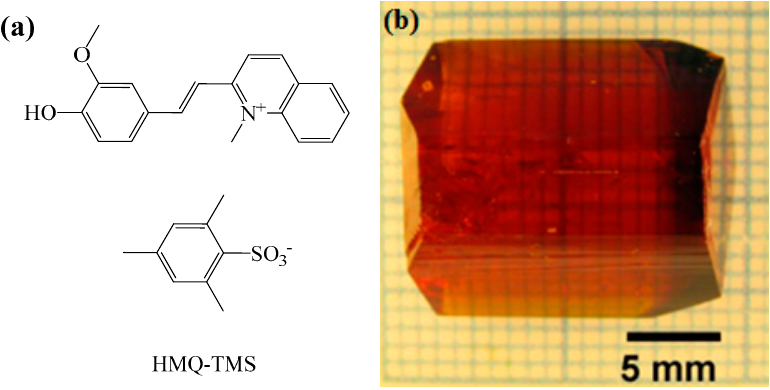
Figure 17. Molecular structure of HMQ-TMS ( a ) and single crystal of HMQ-TMS ( b ).